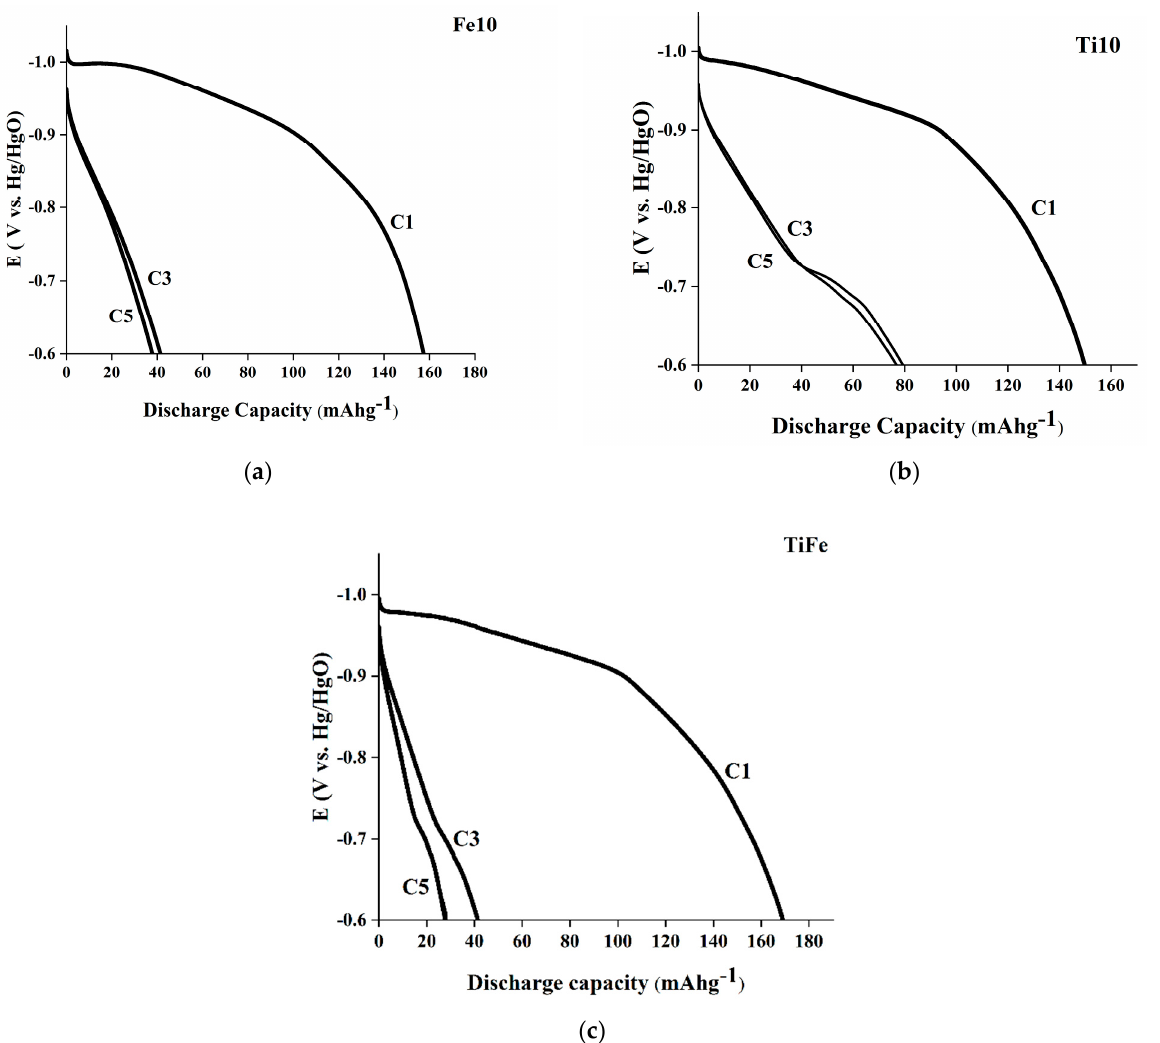
Figure 13. Discharge curves in the first, third, and fifth periods of the 60 h milled products of ( a ) Fe10 ( b ) Ti10 ( c ) TiFe.